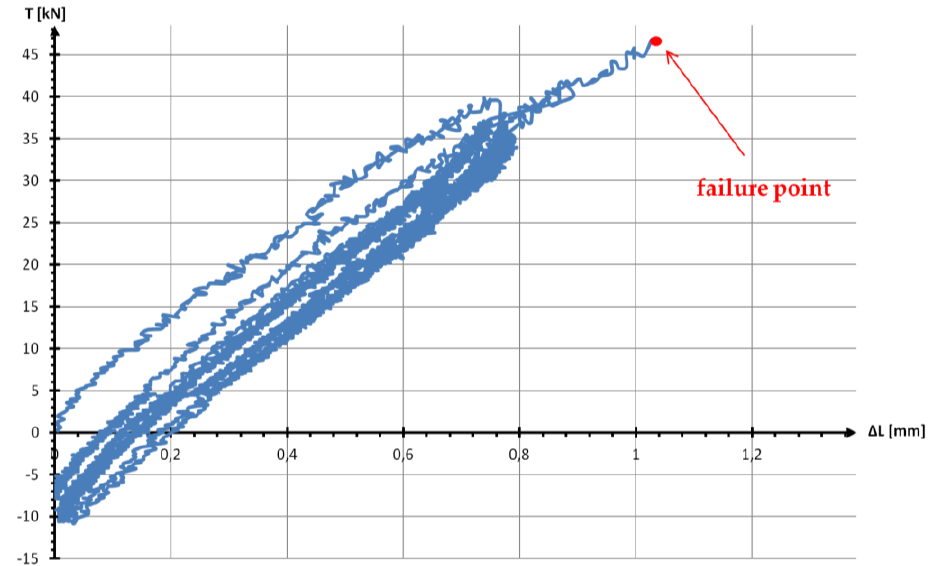
Figure 17. Load versus elongation graph—joint sample “II”.